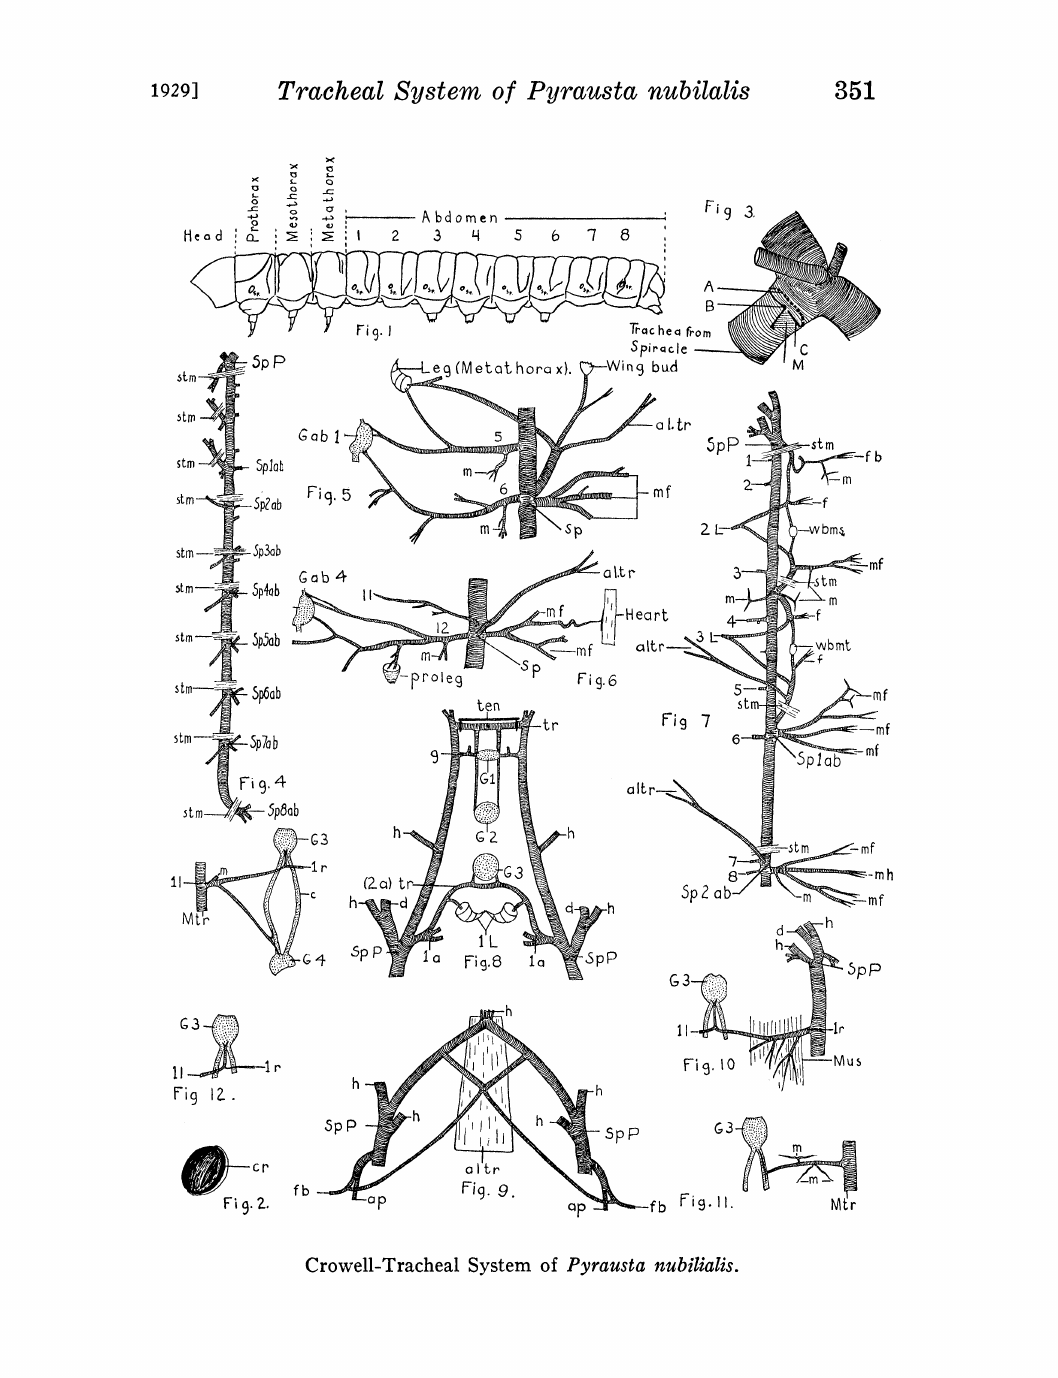
cp fb Fi9,2. fb 7i 9.11. Crowell-Tracheal System of Pyrausta